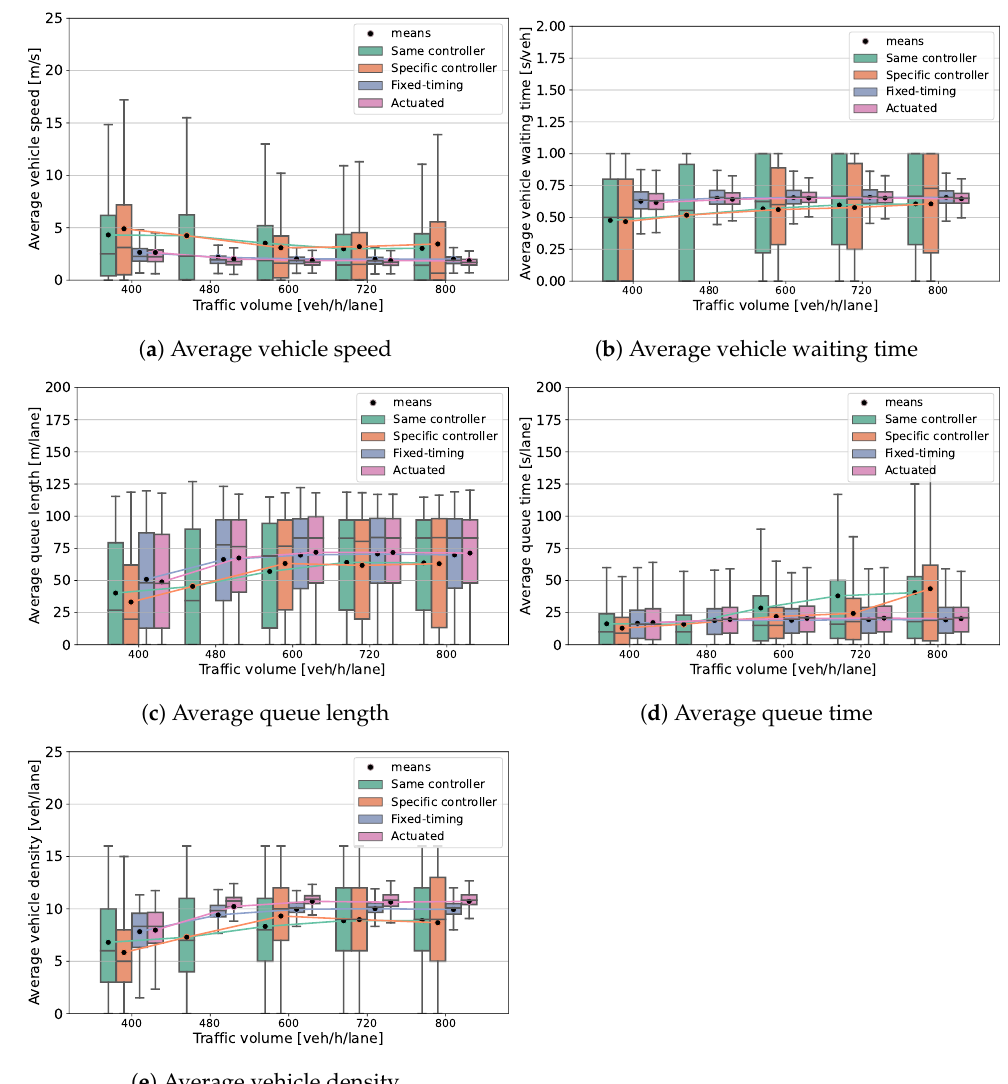
Figure 16. Robustness analysis by comparing the performance of DRL-based